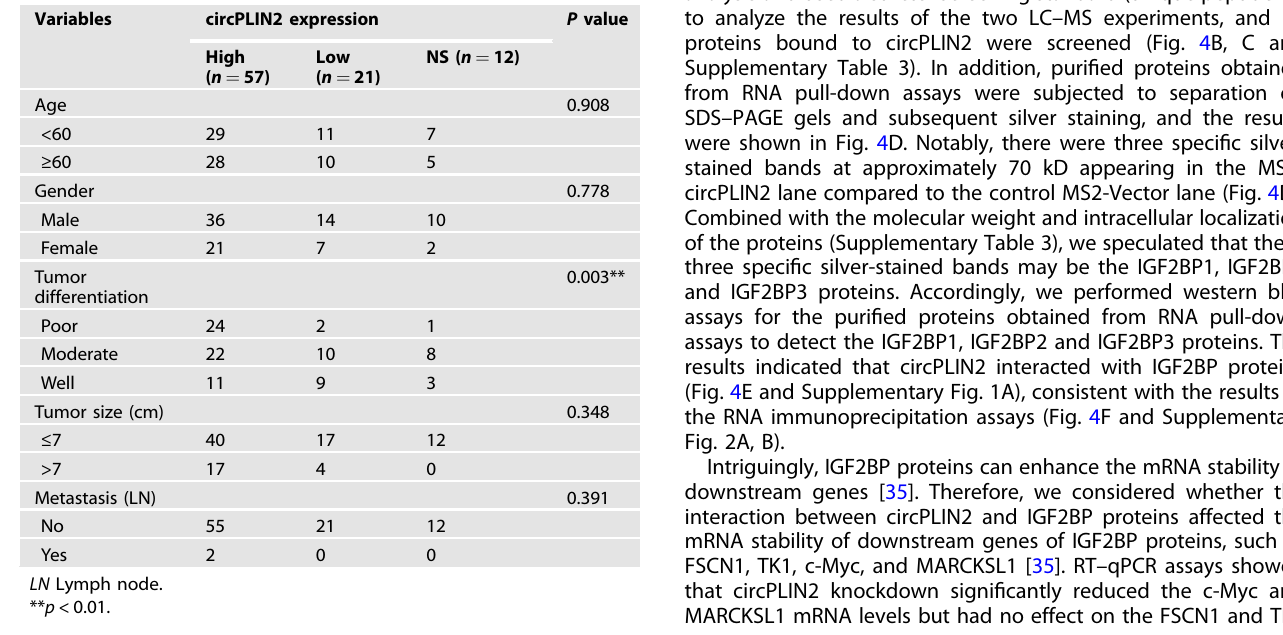
Table 1. The relationship between circPLIN2 expression and the clinicopathological characteristics in 90 ccRCC patients.